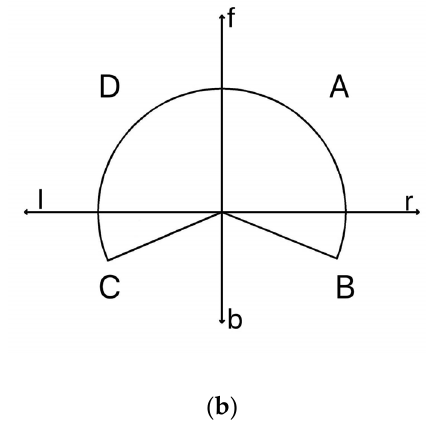
Figure 2. Regional division: ( a ) view angle of ship; ( b ) division of ship area.